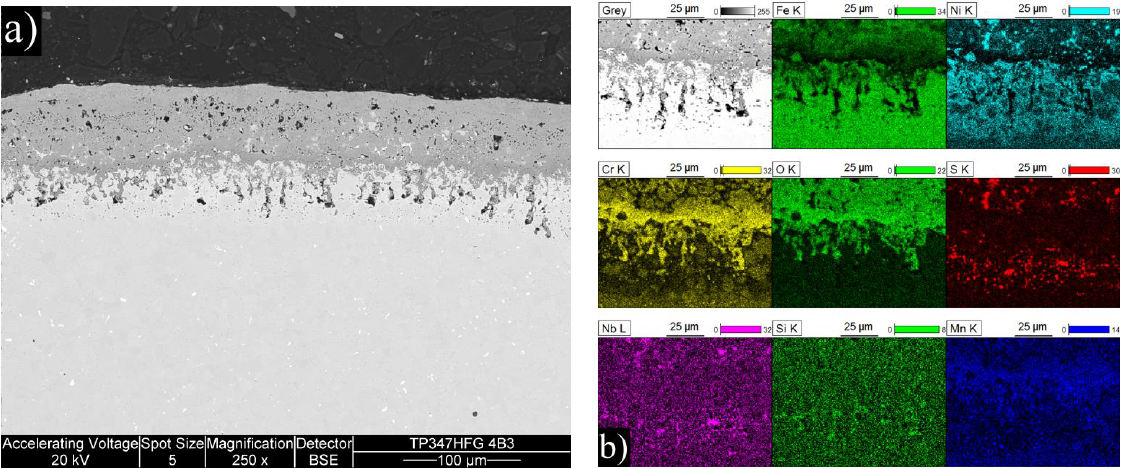
Figure 12. ( a ) SEM image of TP347HFG steel cross-section near the surface after the exposure at 720 °C for 1000 h; ( b ) EDX elemental map of the corrosion front at a higher magnification.